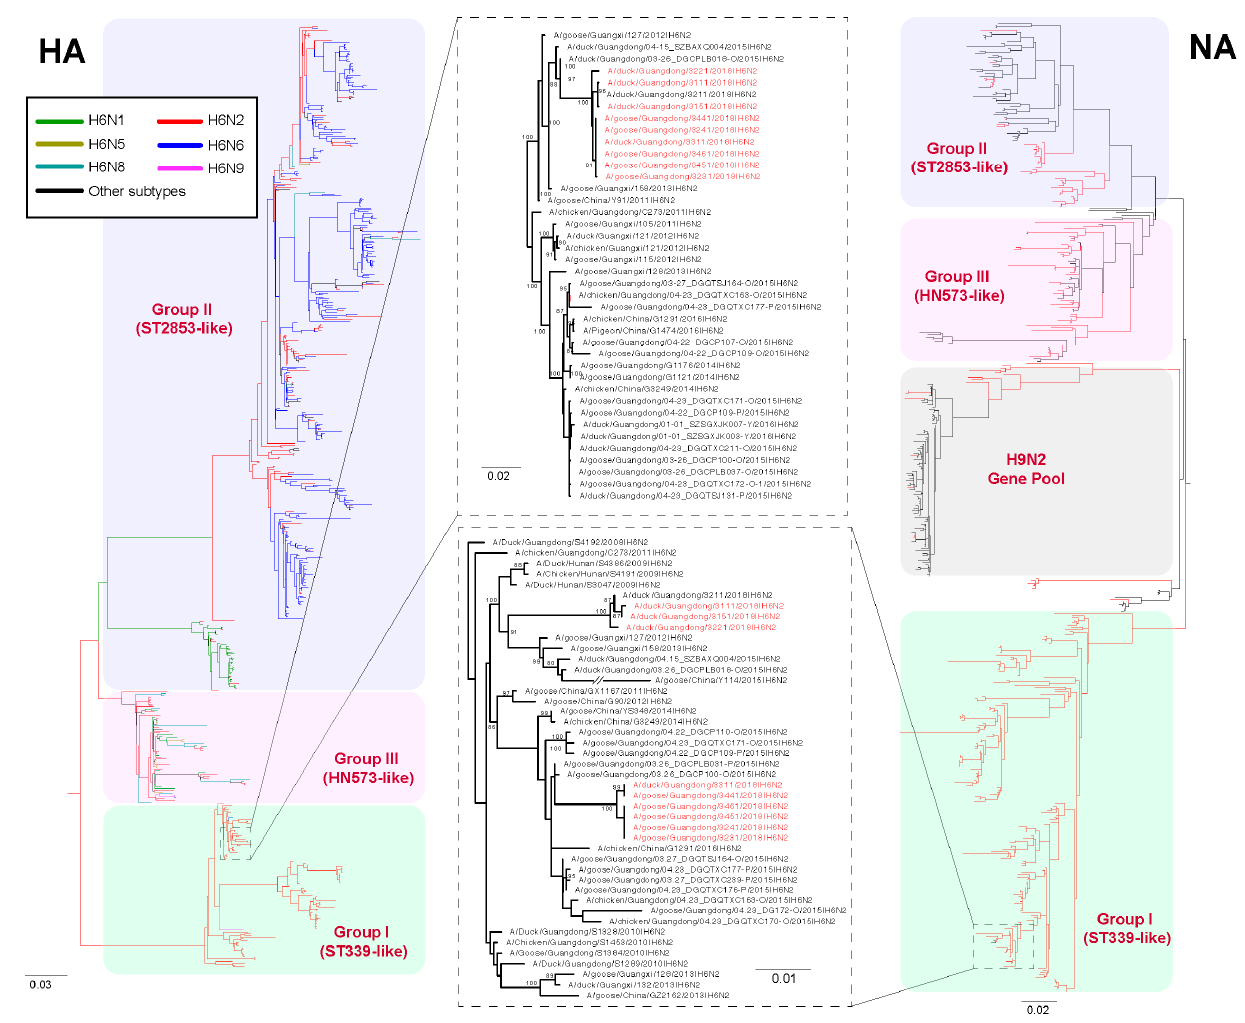
Figure 2. Maximum likelihood tree of HA and NA gene sequences of H6N2 viruses. All of the H6Nx viruses in China, including our new 10 H6N2 viruses, were used to perform the phylogenic analysis. All branch lengths are scaled according to the numbers of substitutions per site (subs/site). Maximum likelihood (ML) phylogenies for the codon alignment of the full gene segments were estimated using the GTR+G nucleotide substitution model in the RAxML (version 8.2) program. Node support was determined by nonparametric bootstrapping with 1000 replicates. The phylogenetic tree was visualized in the FigTree (version 1.4.3) program. Abbreviations: ST339, A/duck/Shantou/339/2000 (H6N2); ST2853, A/wild duck/Shantou/2853/2003 (H6N2); HN573, A/duck/Hunan/573/2002